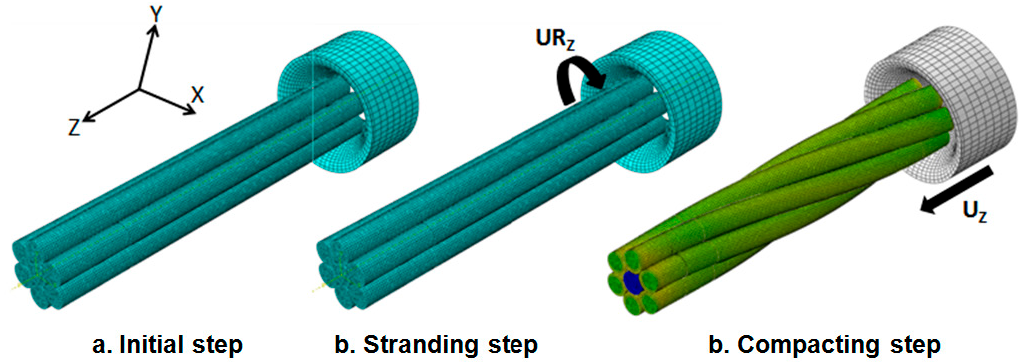
Figure 10. Abaqus stranding and compacting process boundary